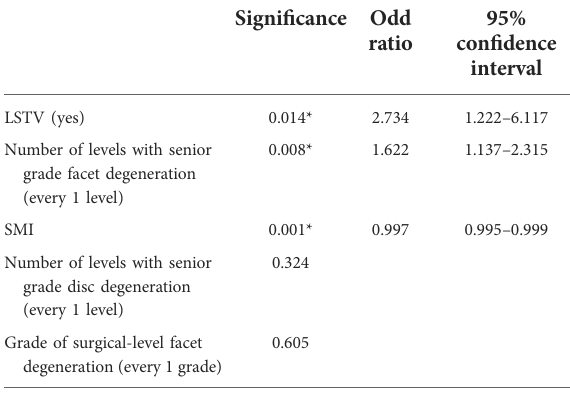
TABLE 3 Univariate analyses of the radiological parameters between patients in the reoperation and control groups.